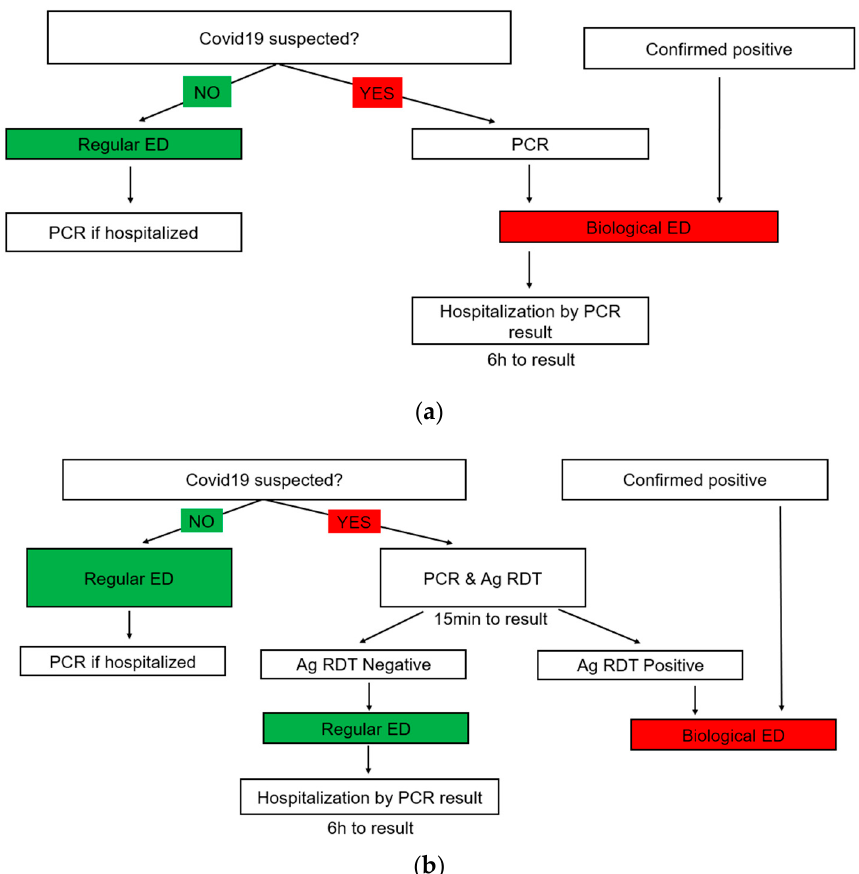
Figure 2. ( a ) The triage protocol during period 1, prior to the introduction of Ag-RDTs to the ED. ( b ) The triage protocol during period 2, while Ag-RDT was used as a decision-support